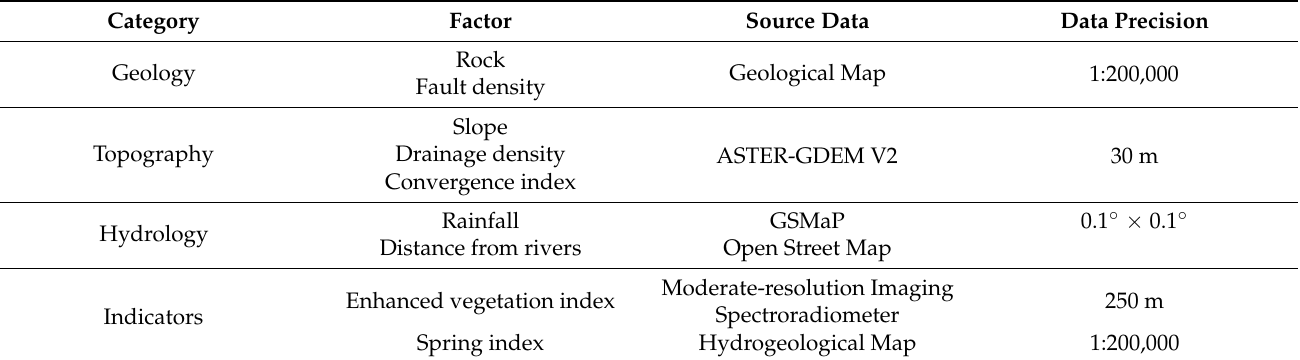
Table 3. Factors and data sources for groundwater potential